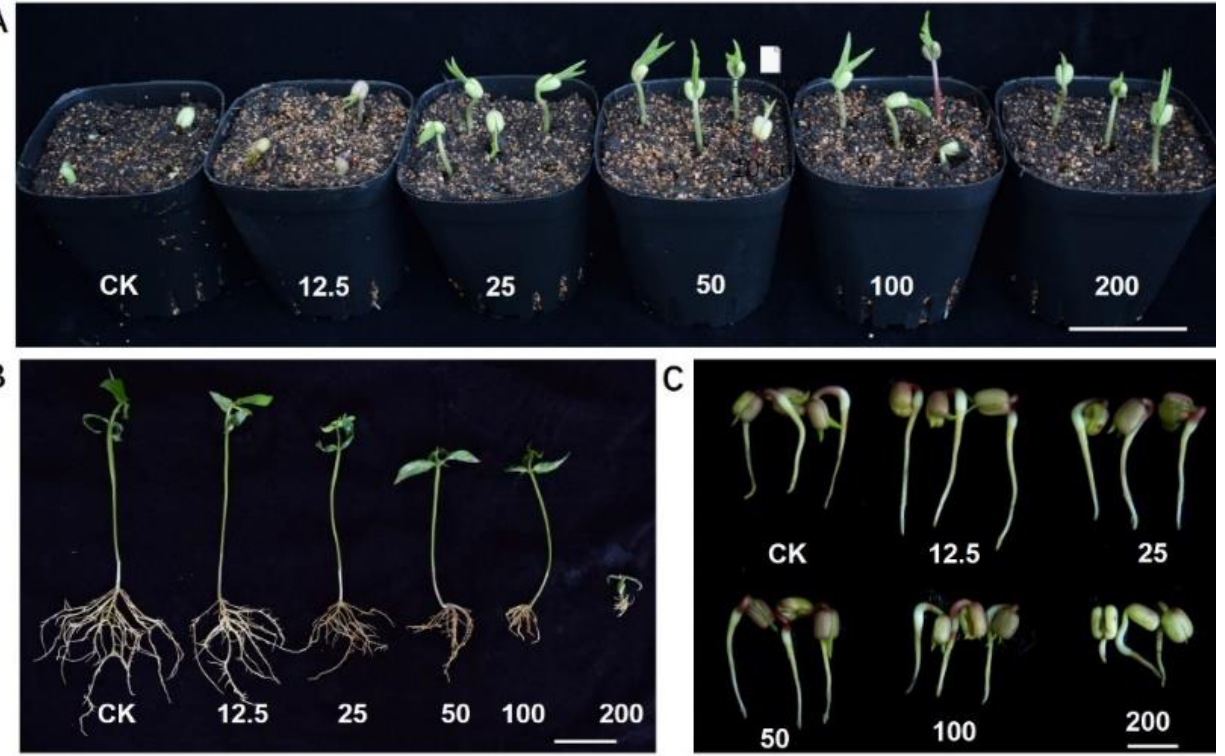
Figure 2. Effects of GO treatment on mung bean seedlings grown in different media. ( A ) Representative image of 5-day-old mung beans planted in soil. Scale bar = 5 cm. ( B ) Representative image of 10-day-old mung beans planted in solid MS medium. Scale bar = 5 cm. ( C ) Representative image of 3-day-old mung beans grown in water solution. Scale bar = 1 cm. Plants were treated with GO to a final concentration of 0, 12.5, 25, 50, 100, or 200 mg/L.